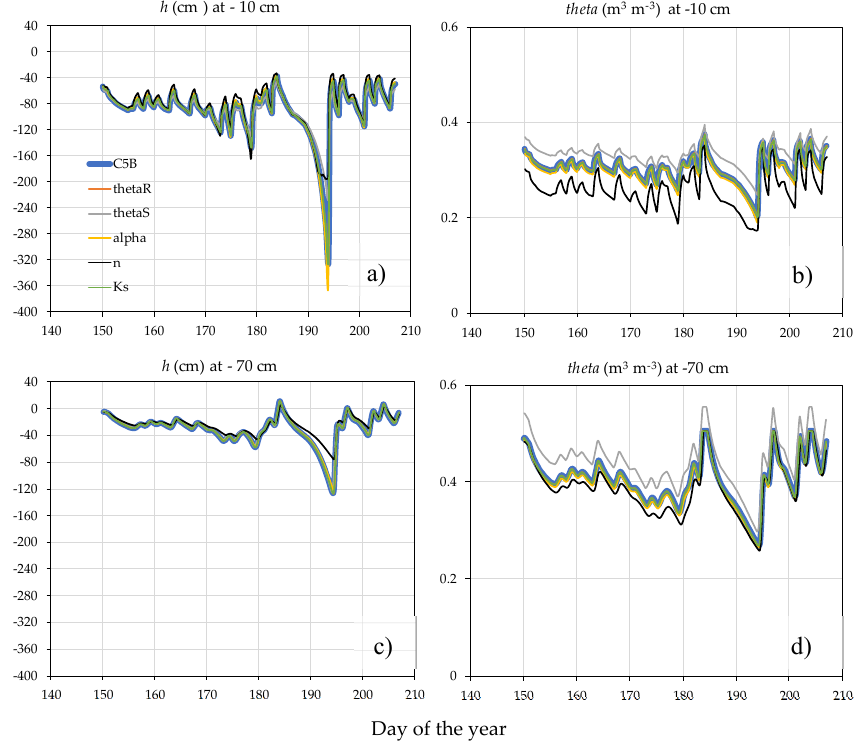
Figure 9. Temporal trend of soil pressure head ( a , c ) and soil water content ( b , d ) obtained by perturbating the van Genuchten parameters under the C5